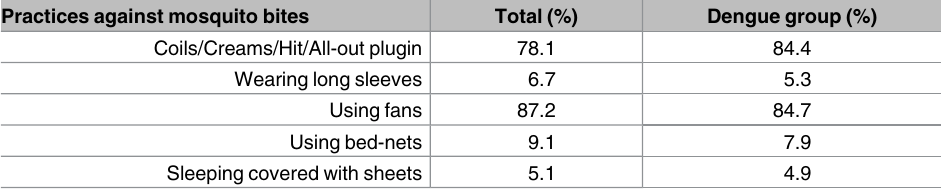
Table 2. Individual protection against mosquito bites in the survey population (N = 3,350) and in den- gue household group (N = 263). Practices against mosquito